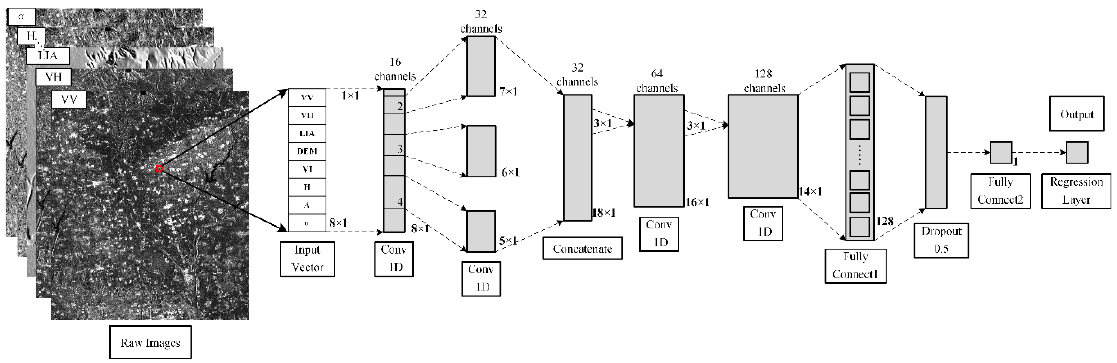
Figure 2. Structure of regression convolutional neural network (CNNR) in this study.